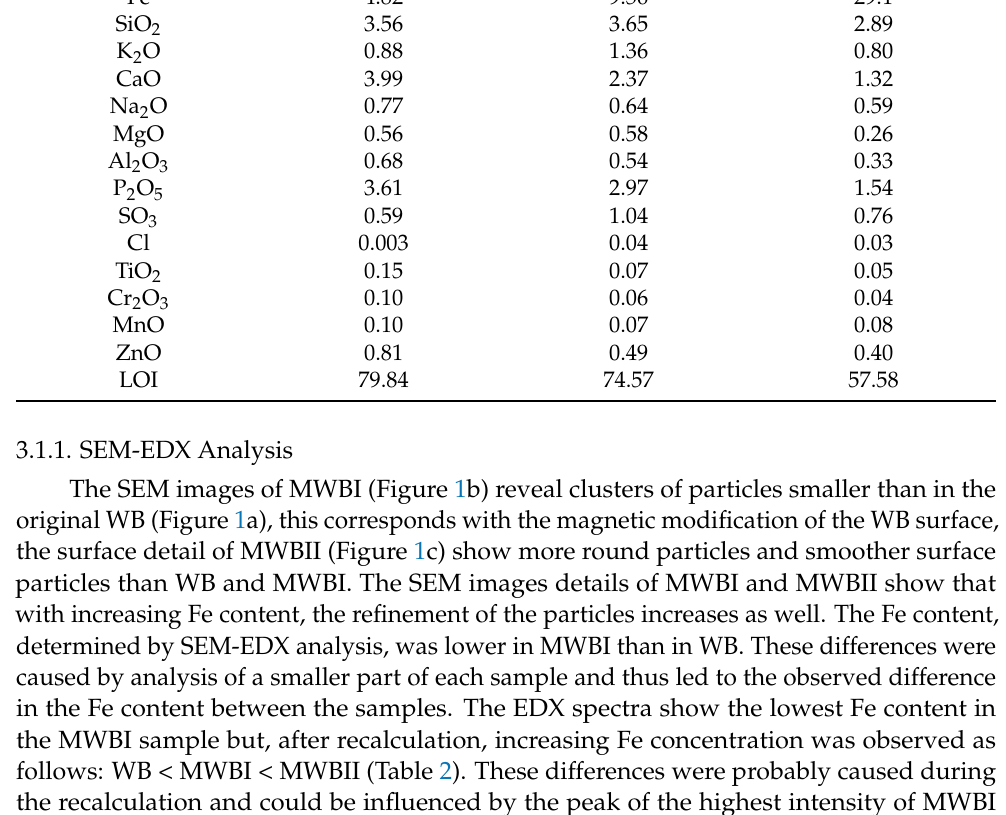
Table 1. The total content of minor elements determined in WB, MWBI, and MWBII expressed in oxides, besides the Fe and Cl. LOI—lost on ignition. Content WB (wt.%) MWBI